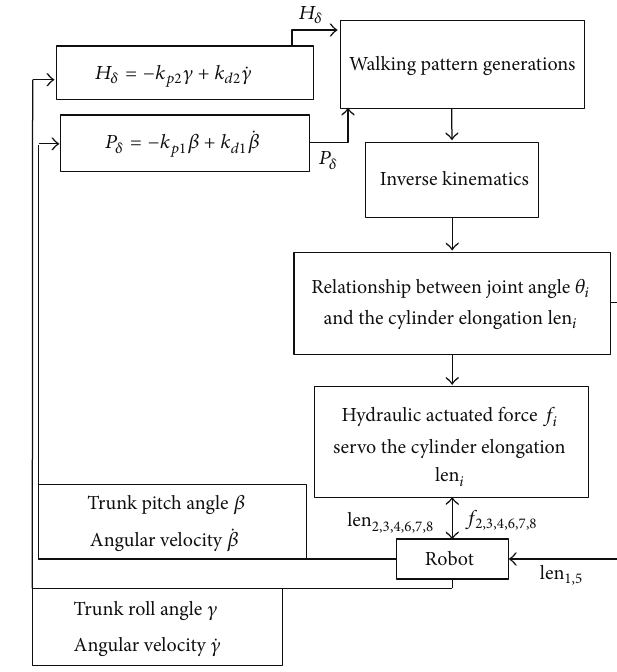
Figure 7: Diagram of the ground reaction force.